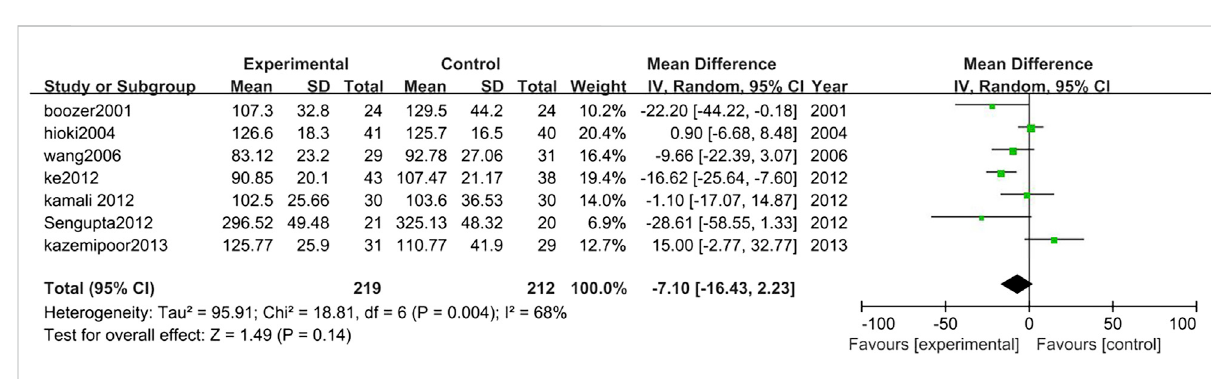
FIGURE 10 Forest plot of LDL. Comparison: TCM treatment vs. placeo or blank control.